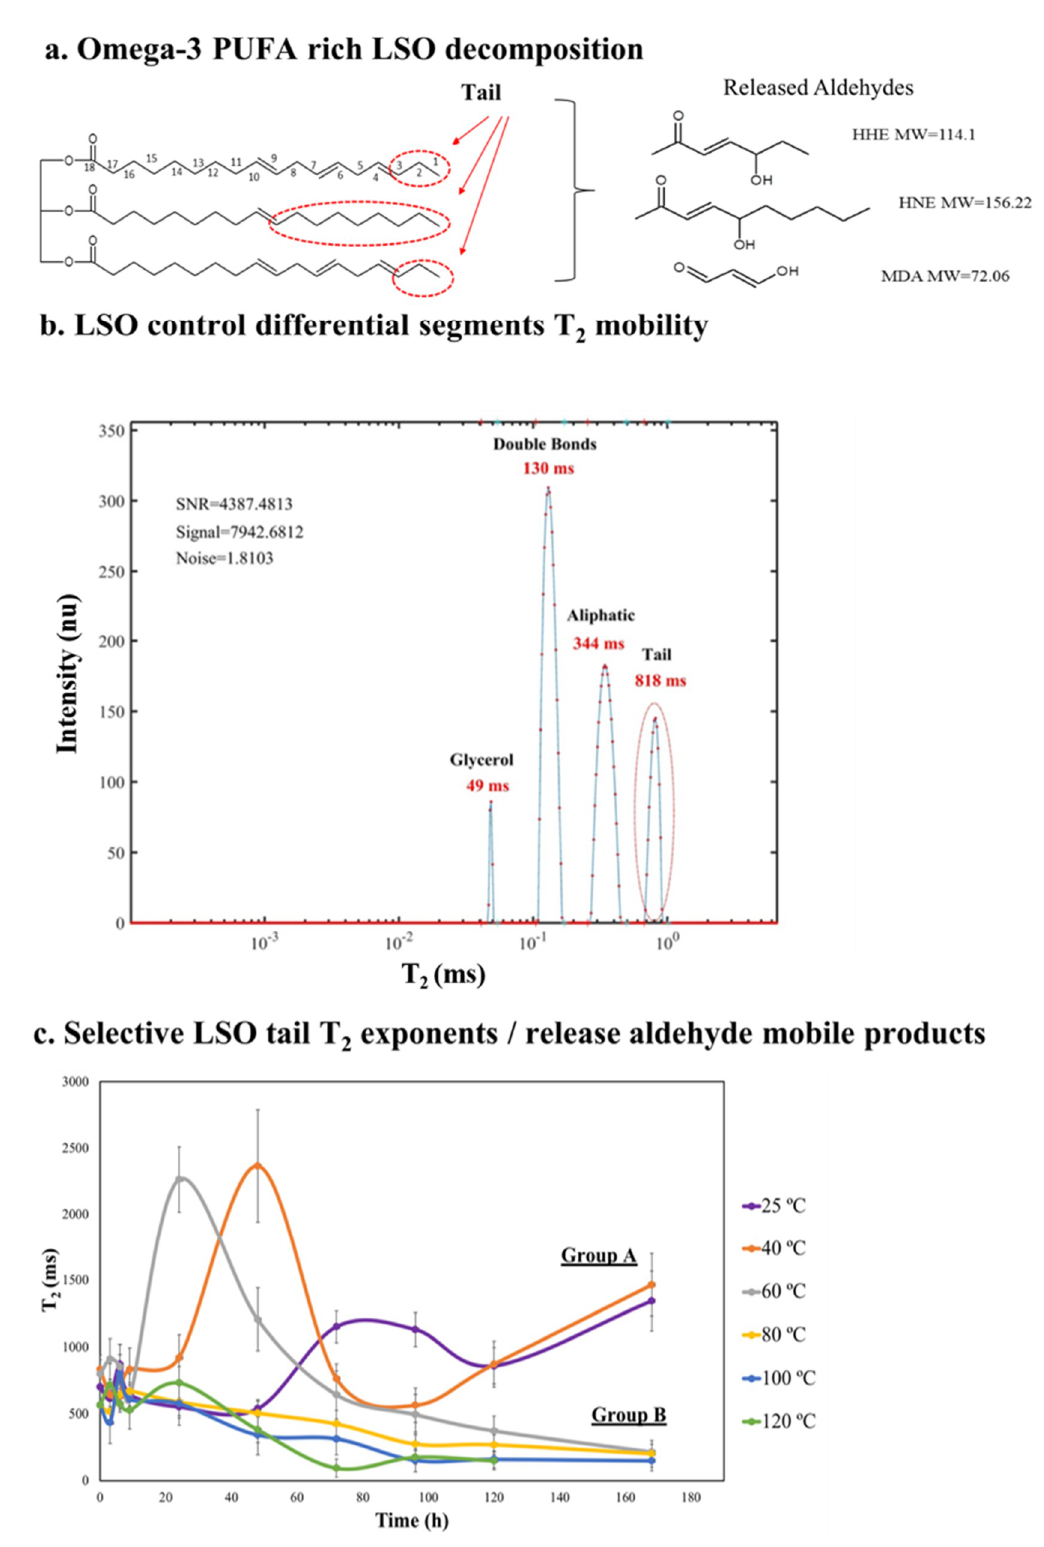
Figure 13. ( a ) Omega-3 linolenic acid-rich LSO decomposition pattern and main released aldehydes as determined by GC–MS analysis, ( b ) selective exponents of LSO segments with emphasis of segment of tail T 2 time domain relaxation determination ( c ) and graphic presentation of LSO tail T 2 changes during heating at 25, 40, 60, 80, 100 and 120 ◦ C together with air pumping for 168 h (25 and 40 ◦ C designated as Group A and 60, 80, 100 and 120 ◦ C designated as Group B). Mean ± SD is presented for each T 2 time point. Reprinted with permission from ref. [24]. Copyright 2019